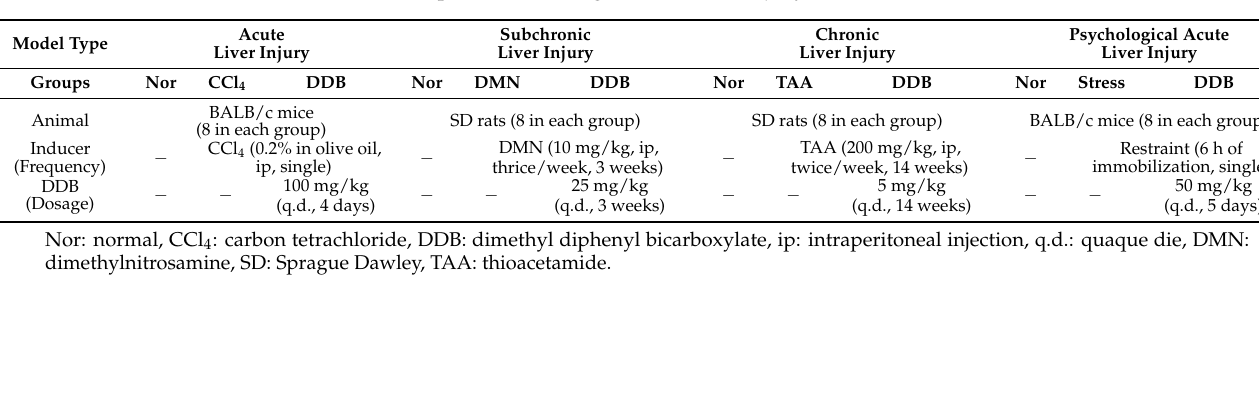
Table 1. Experimental design of four liver injury animal